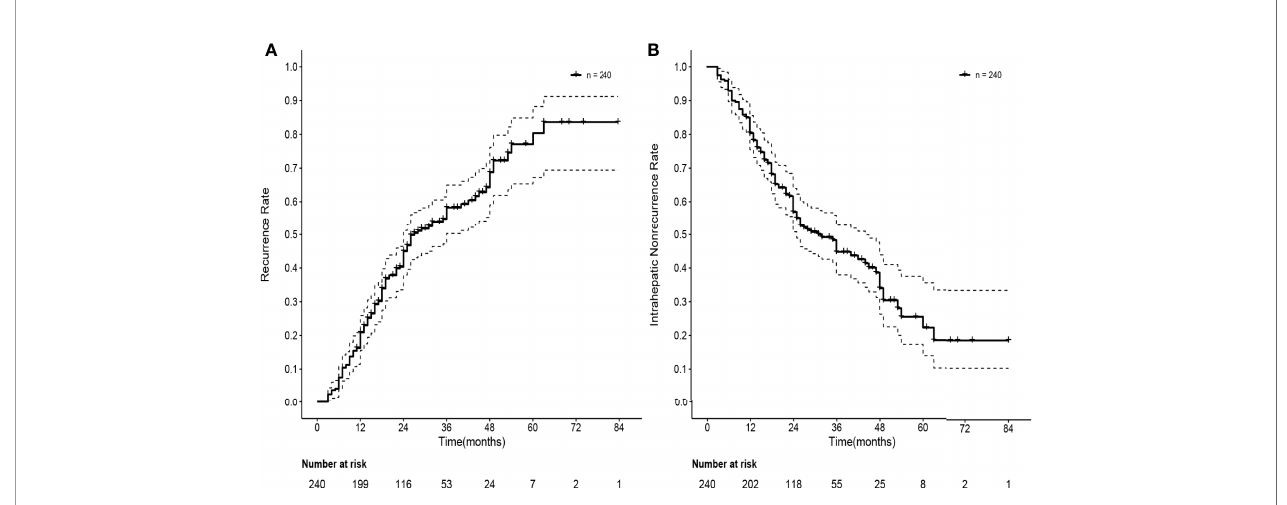
FIGURE 3 | Curves of recurrence rate and intrahepatic nonrecurrence rate of 240 HBV-related sHCC patients after SBRT. (A) Curve of recurrence rate of 240 HBV- related sHCC patients. (B) Curve of intrahepatic nonrecurrence of 240 HBV-related sHCC patients. HBV, hepatitis B virus; sHCC, small hepatocellular carcinoma; SBRT, stereotactic body radiation therapy.